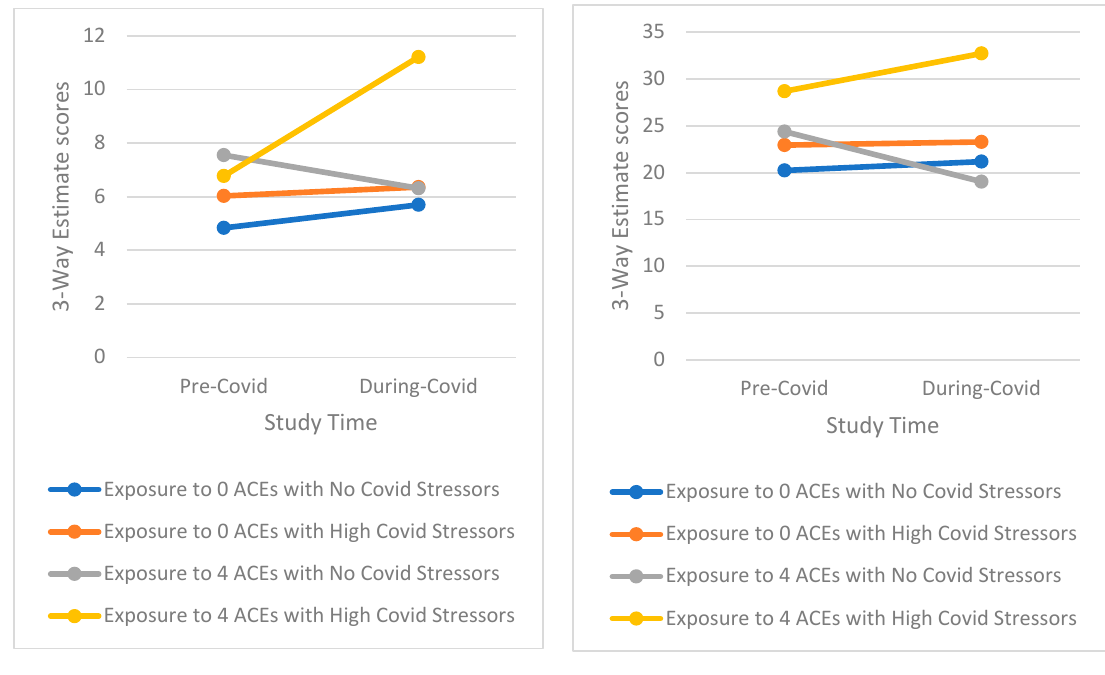
Figure 3. ( a ) Interaction of greater exposure to ACEs and high levels of Loneliness on Changes in Hostility Symptomatology among Young Adults from Before to During the COVID-19 Pandemic; ( b ) Interaction of greater exposure to ACEs and low levels of Physical Activity on Changes in Hostility Symptomatology among Young Adults from Before to During the COVID-19 Pandemic.